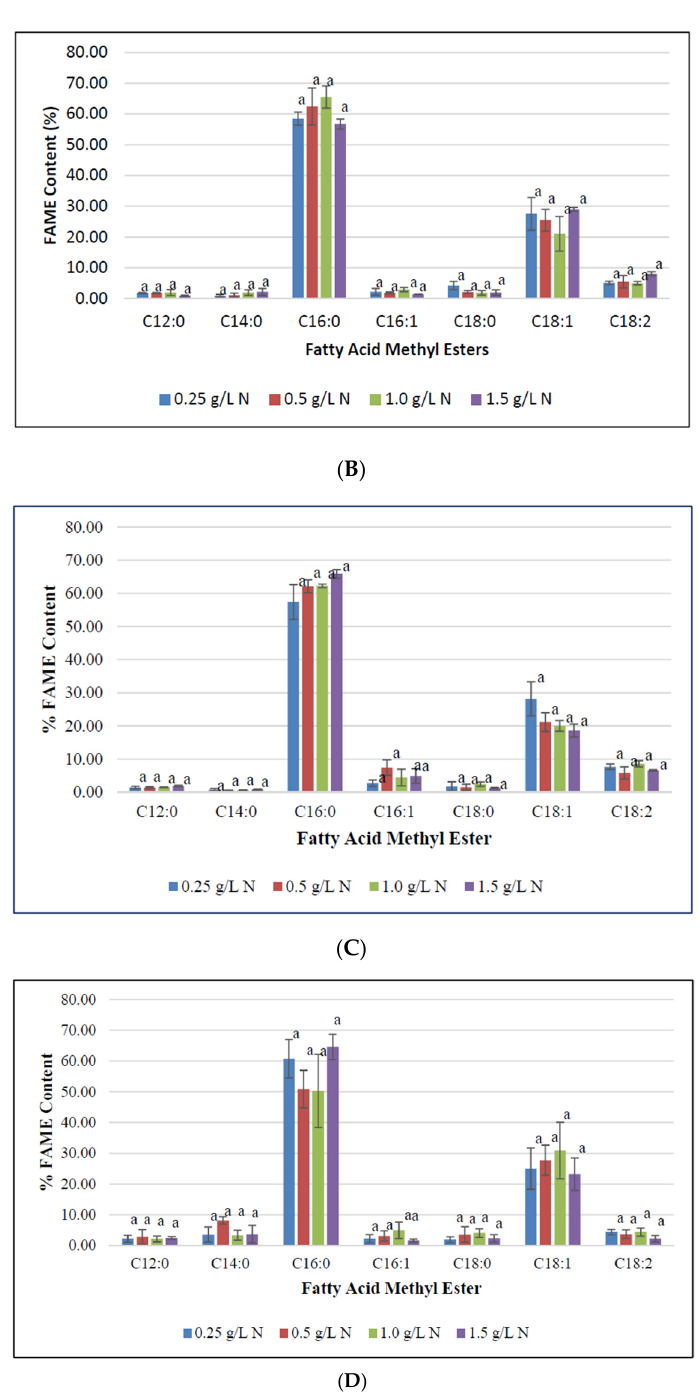
Figure 3. Fatty methyl ester composition (FAME) of Fremyella diplosiphon grown over ( A ) 7, ( B ) 10, ( C ) 15, and ( D ) 20 days in media containing 0.25, 0.5, 1.0, 1.5 g L − 1 sodium nitrate (NaNO 3 ). Bars represent the average % relative content of specific FAME species (± standard error) for three biological replicates of each nitrate treatment. Different letters above bars indicate significant differences in FAME species abundance between varying nitrate treatments ( p < 0.05).